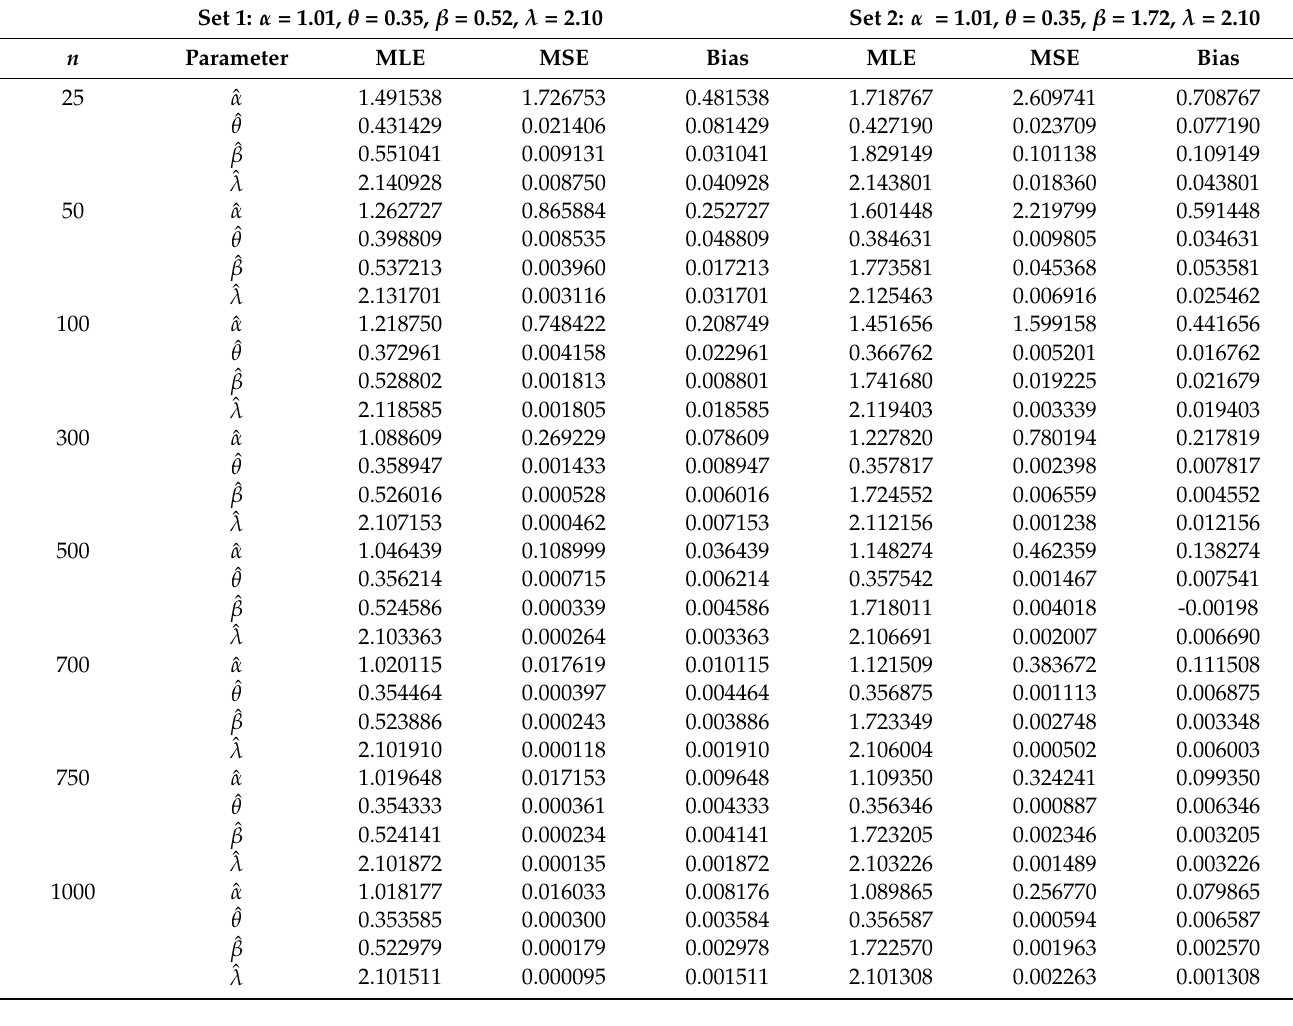
Table 1. Results of the simulation (MLE, MSE, and bias) for GAEPPRD are reported.